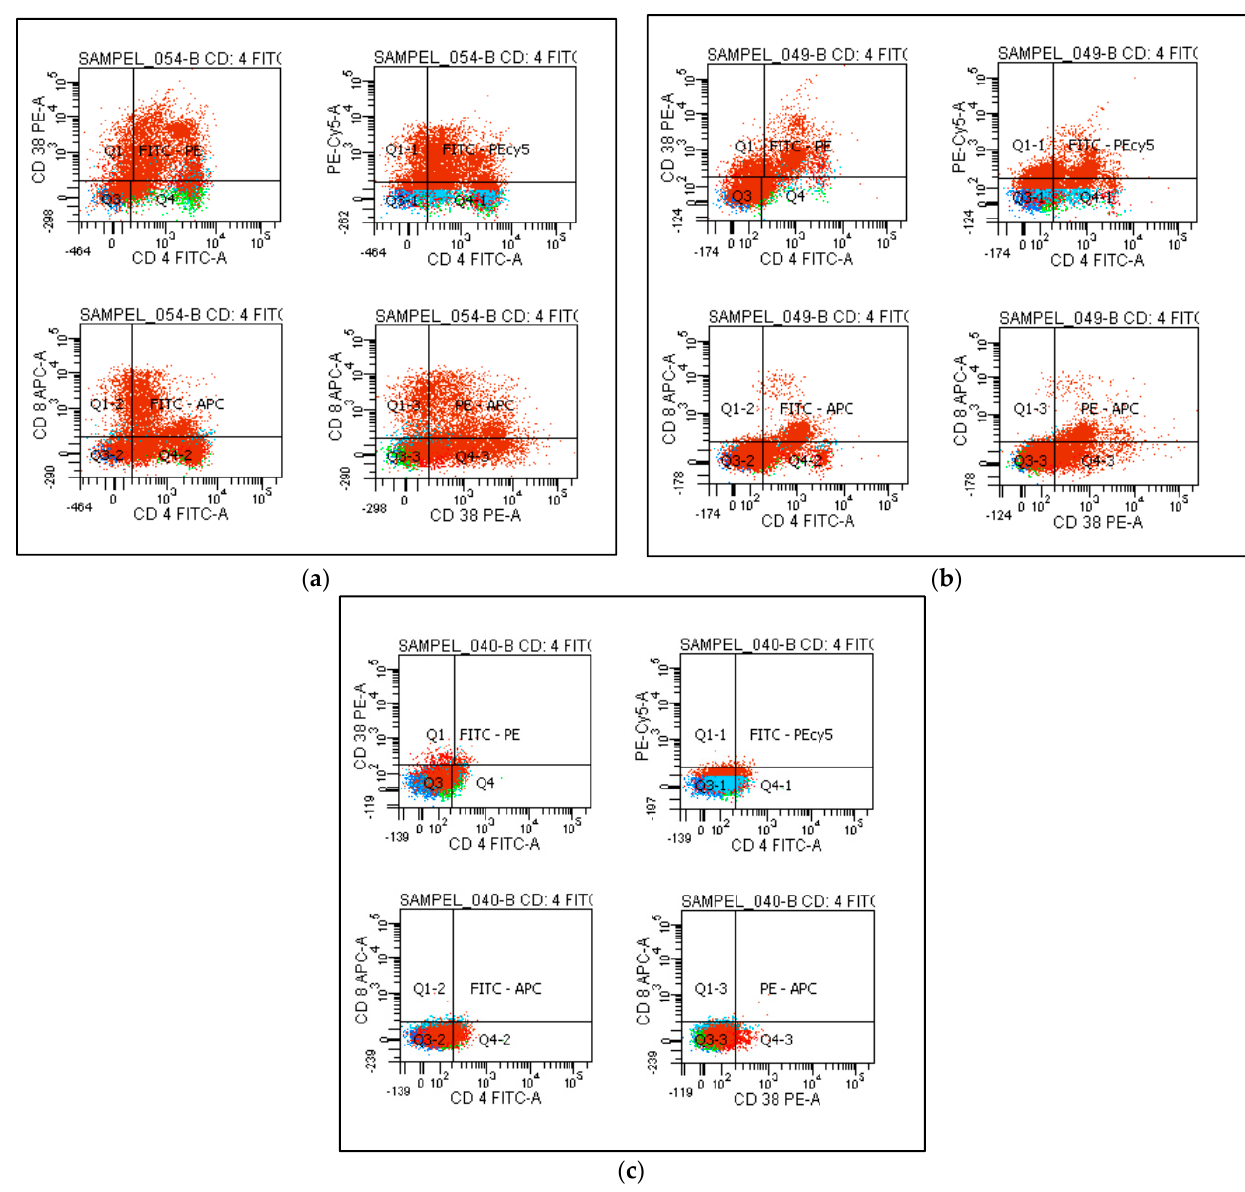
Figure 1. Co-expression of CD38 on CD4 + T cells and CD8 + T cells. An example of flow cytometry analysis showing the expression of CD38 on both CD4 and CD8 T cells is represented in different groups up of patients as ( a ) mild group, ( b ) moderate group, and ( c ) severe group.